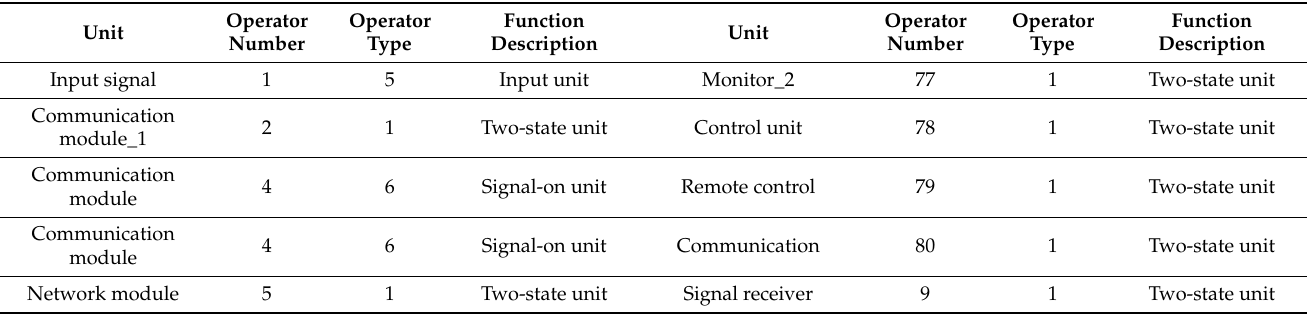
Figure 3. GO graph model for system reliability. Table 2. The C 4 ISR System software and hardware unit and their logical